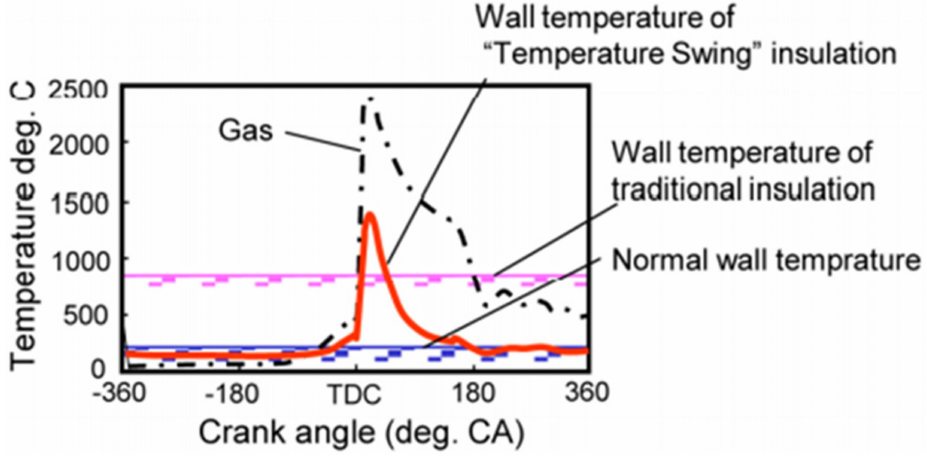
Figure 13. Gasandwalltemperaturehistoriesfortraditionalandtemperatureswing insulation method